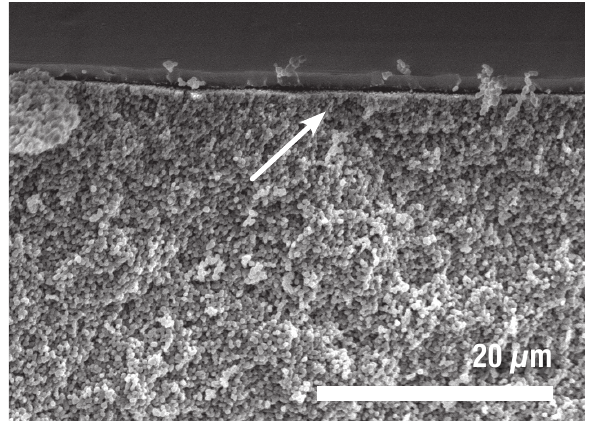
Figure 7: Scanning electron micrograph of the cross-section view of the triple Teflon coated ceramic membrane after temperature treatment at 150 °C. The white arrow indicates the Teflon AF 2400 layer.